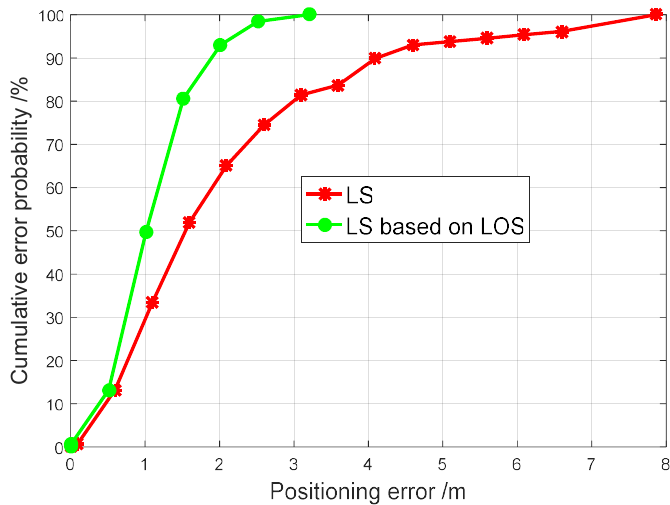
Figure 11. The CDFs of positioning errors of the LS algorithm and LS algorithm based on LOS.